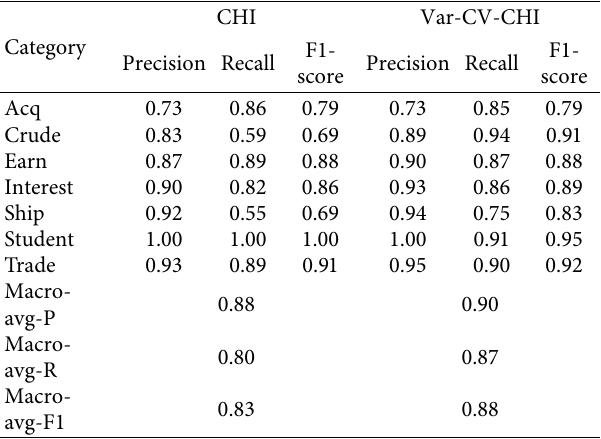
Table 8: Comparison of classification results between CHI and Var-CV-CHI on the unbalanced English corpus (KNN).